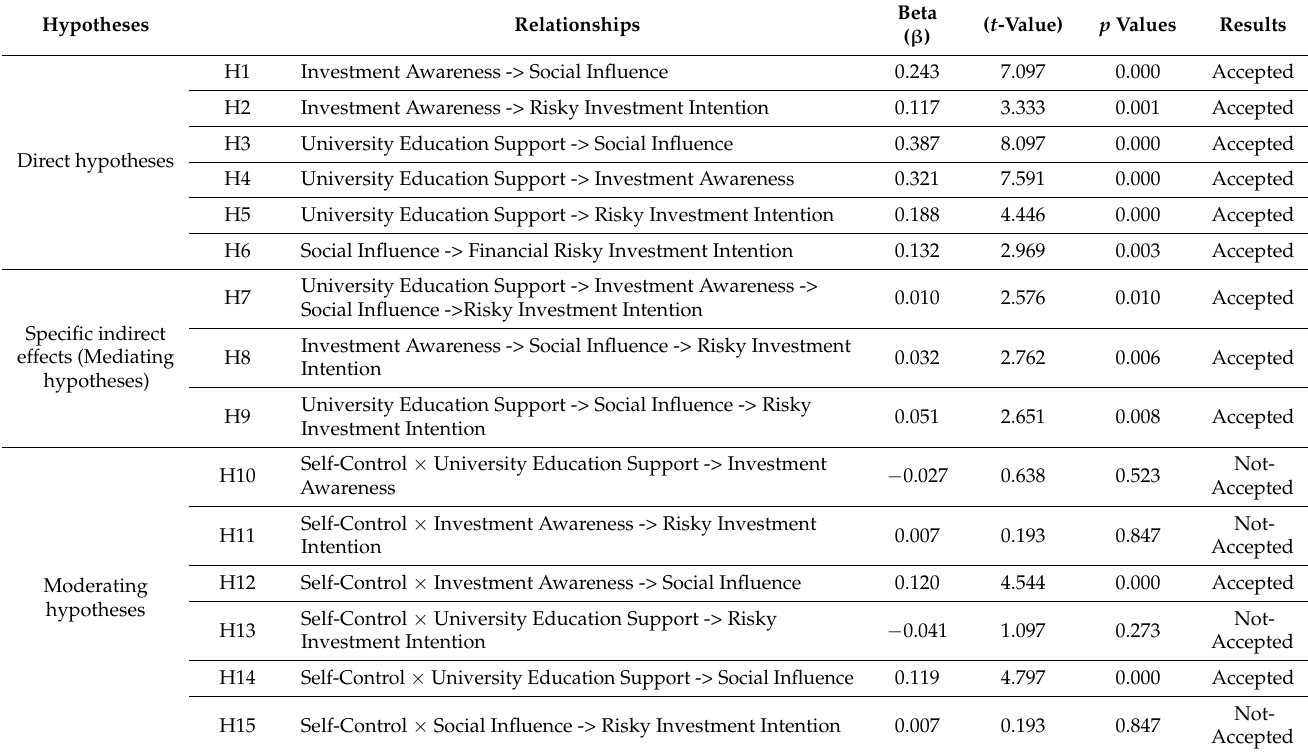
Table 5. The proposed model’s